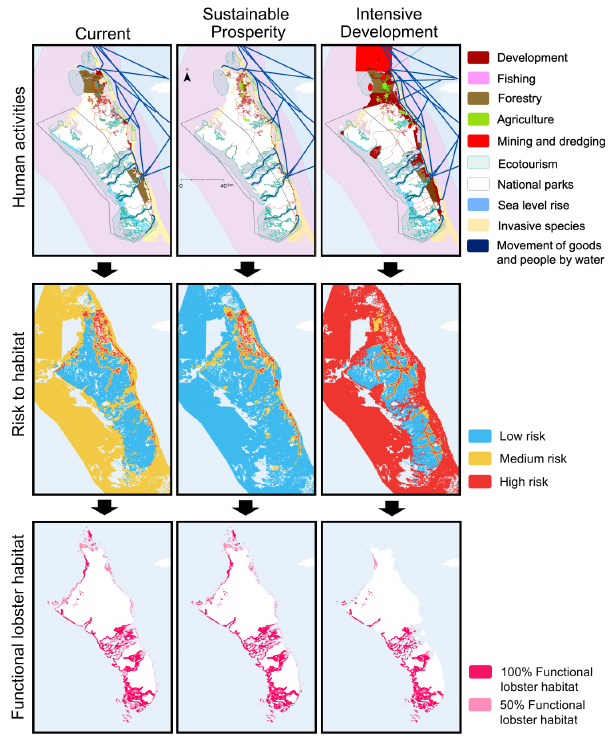
Fig. 7 . Human activities (top row), risk to mangrove and seagrass habitat from human activities (middle row), and functional lobster habitat in and around Andros for the current, sustainable prosperity, and intensive development scenarios, respectively. The third row maps show functional lobster habitat based on the risk results and nursery habitat classification (see Methods